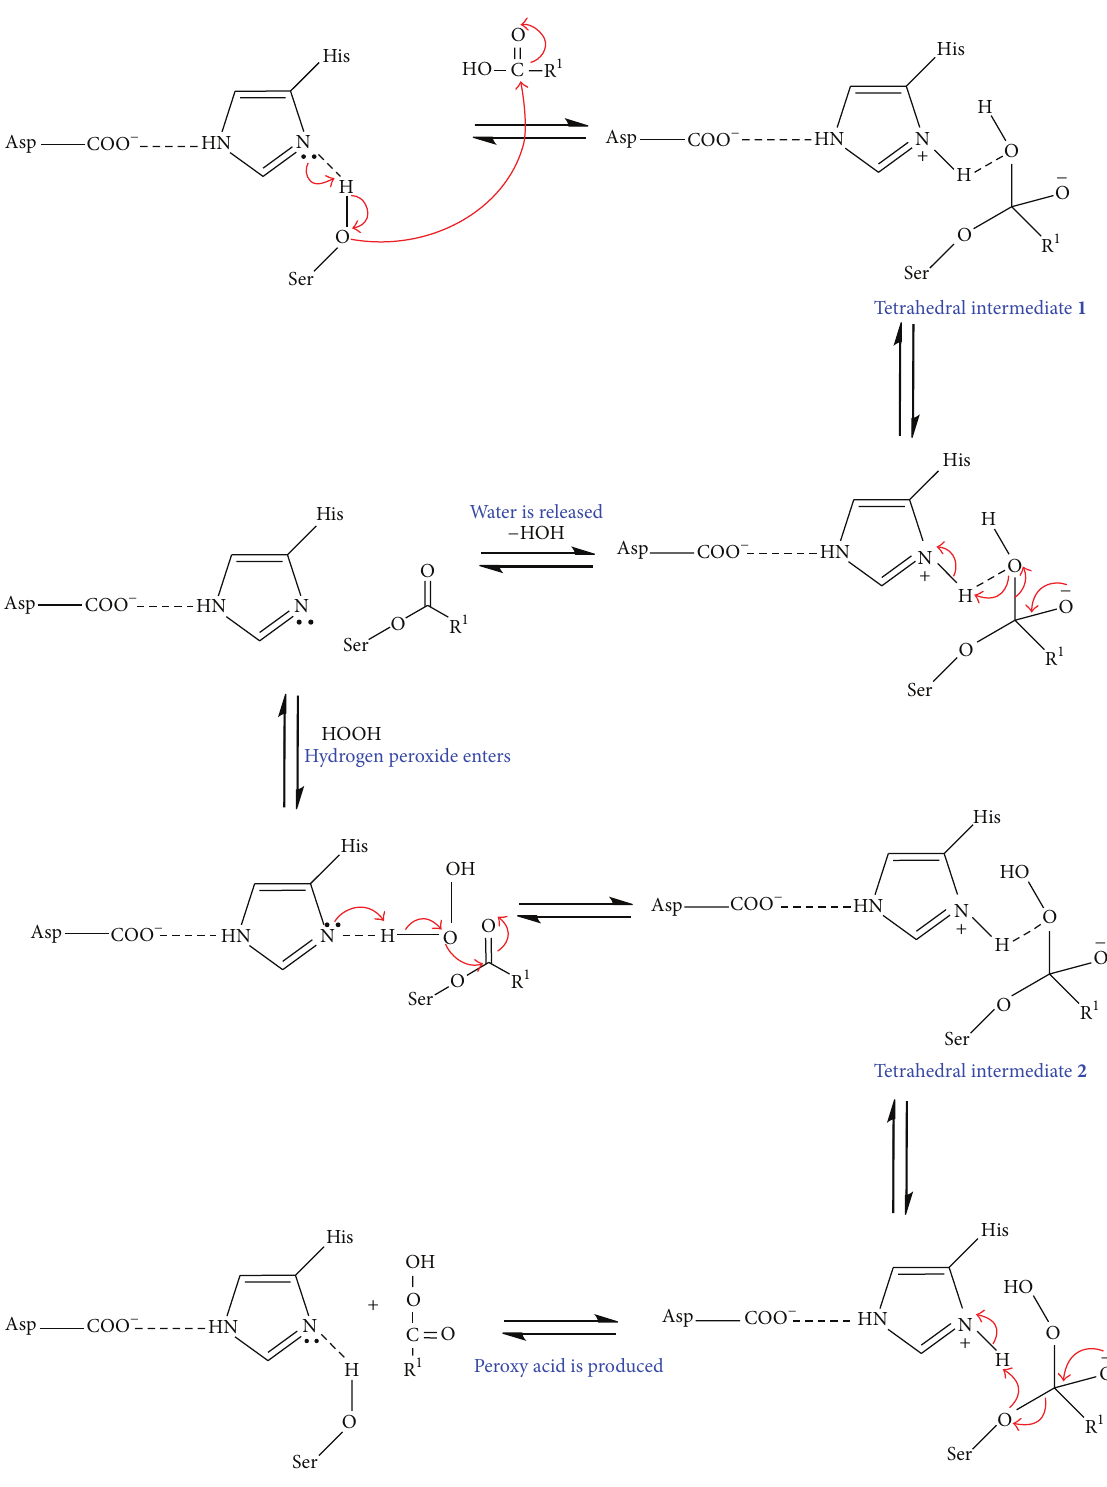
Scheme 1: Mechanism of lipase-catalysed perhydrolysis reaction